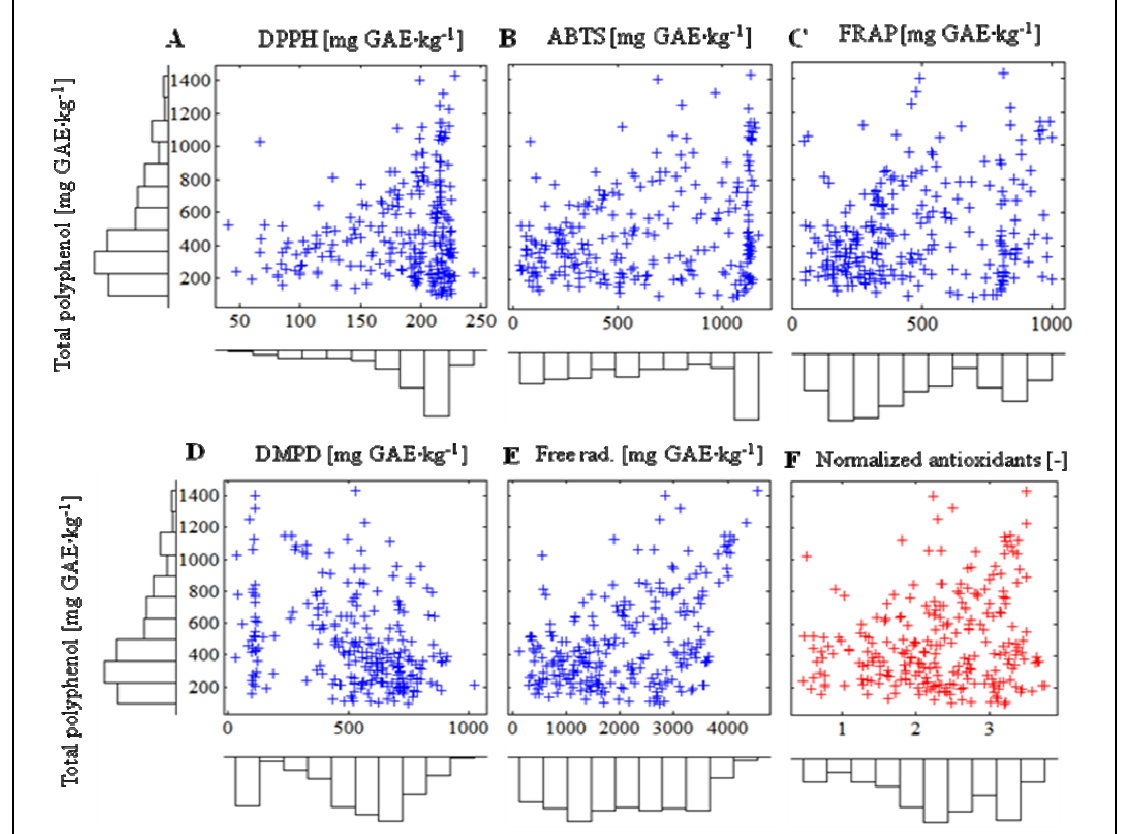
Figure 10. Histograms of distribution of values of antioxidant activity related to total polyphenol